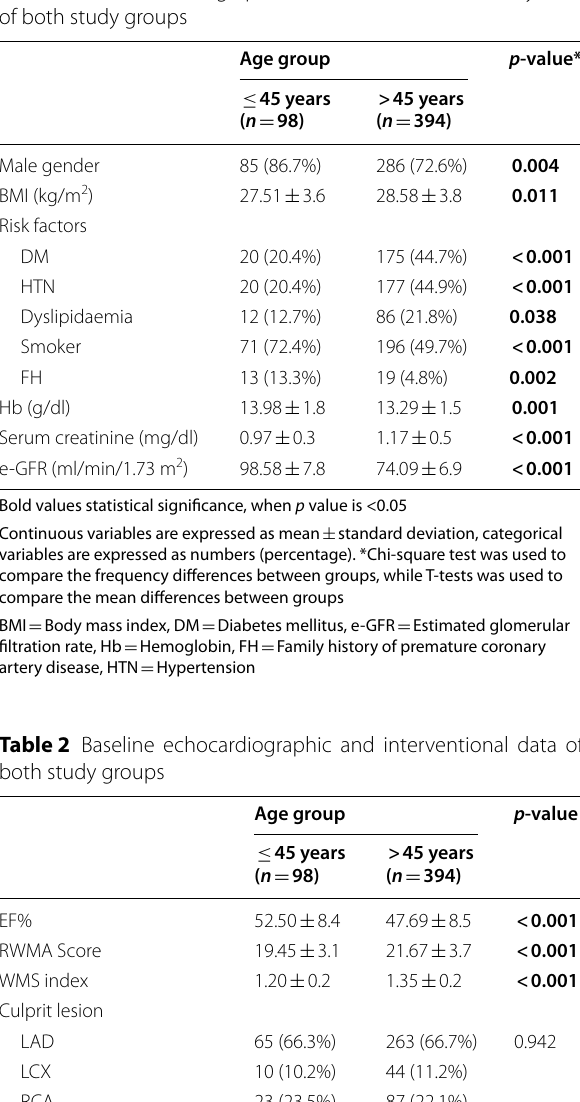
Table 1 Baseline demographic, risk factors and laboratory data